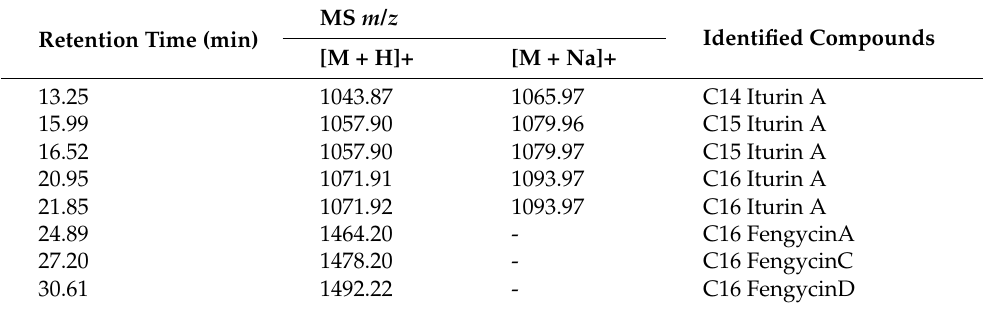
Figure 7. HPLC-MS for the LPs antibiotics isolated from strain E2. Table 4. LC-MS detection of purified LPs.